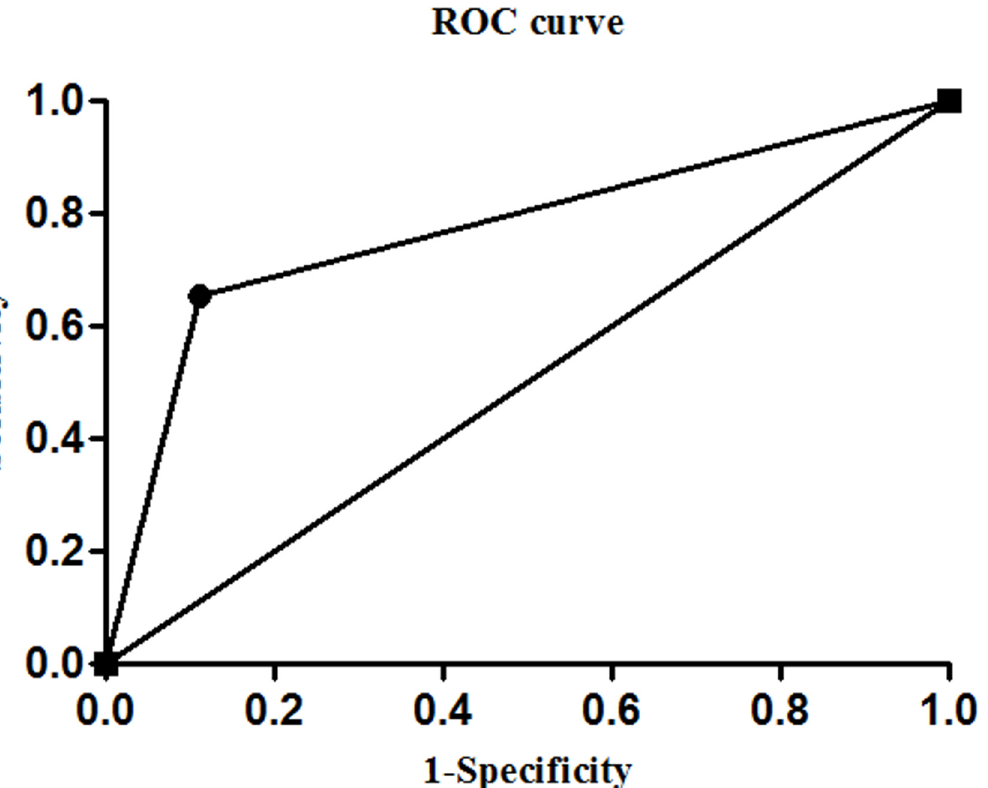
Fig 4. Combined detection of Zic1 promoter methylation and the CEA level (parallel testing) in gastric intraepithelial neoplasia (GPI) plasma specimens. An ROC curve for evaluating the significance of the combined detection of these two parameters for GPI diagnosis.